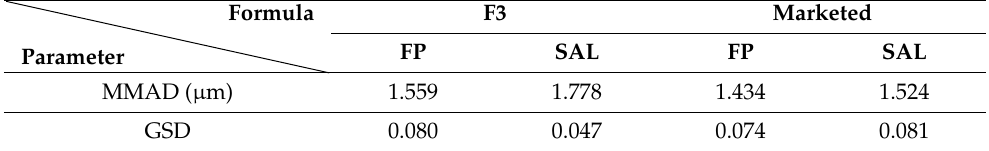
Table 4. MMAD and GSD of the (FP-SAL/Lys-PA) NCs and the marketed product.